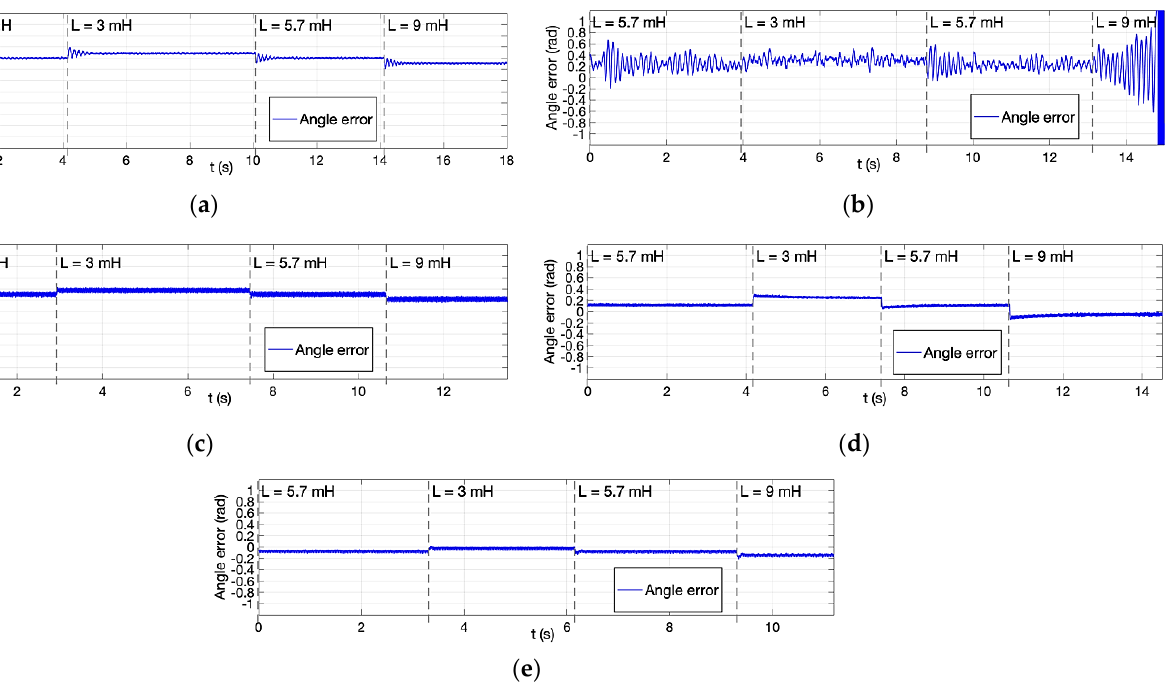
Figure 16. Position estimation error after introducing variations in the stator inductance value: ( a ) ELADRC algorithm; ( b ) FACCF-SMO algorithm; ( c ) nonlinear RFO; ( d ) adaptive RFO; ( e ) regression RFO. Table 4. Position estimation error with mismatches in the value of 𝐿 𝑠 at 10% of rated speed. Algorithm